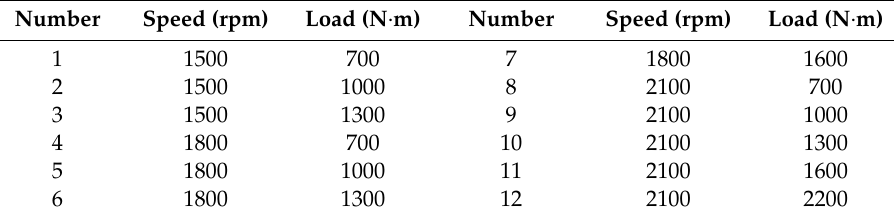
Table 2. Twelve experiment operating conditions.